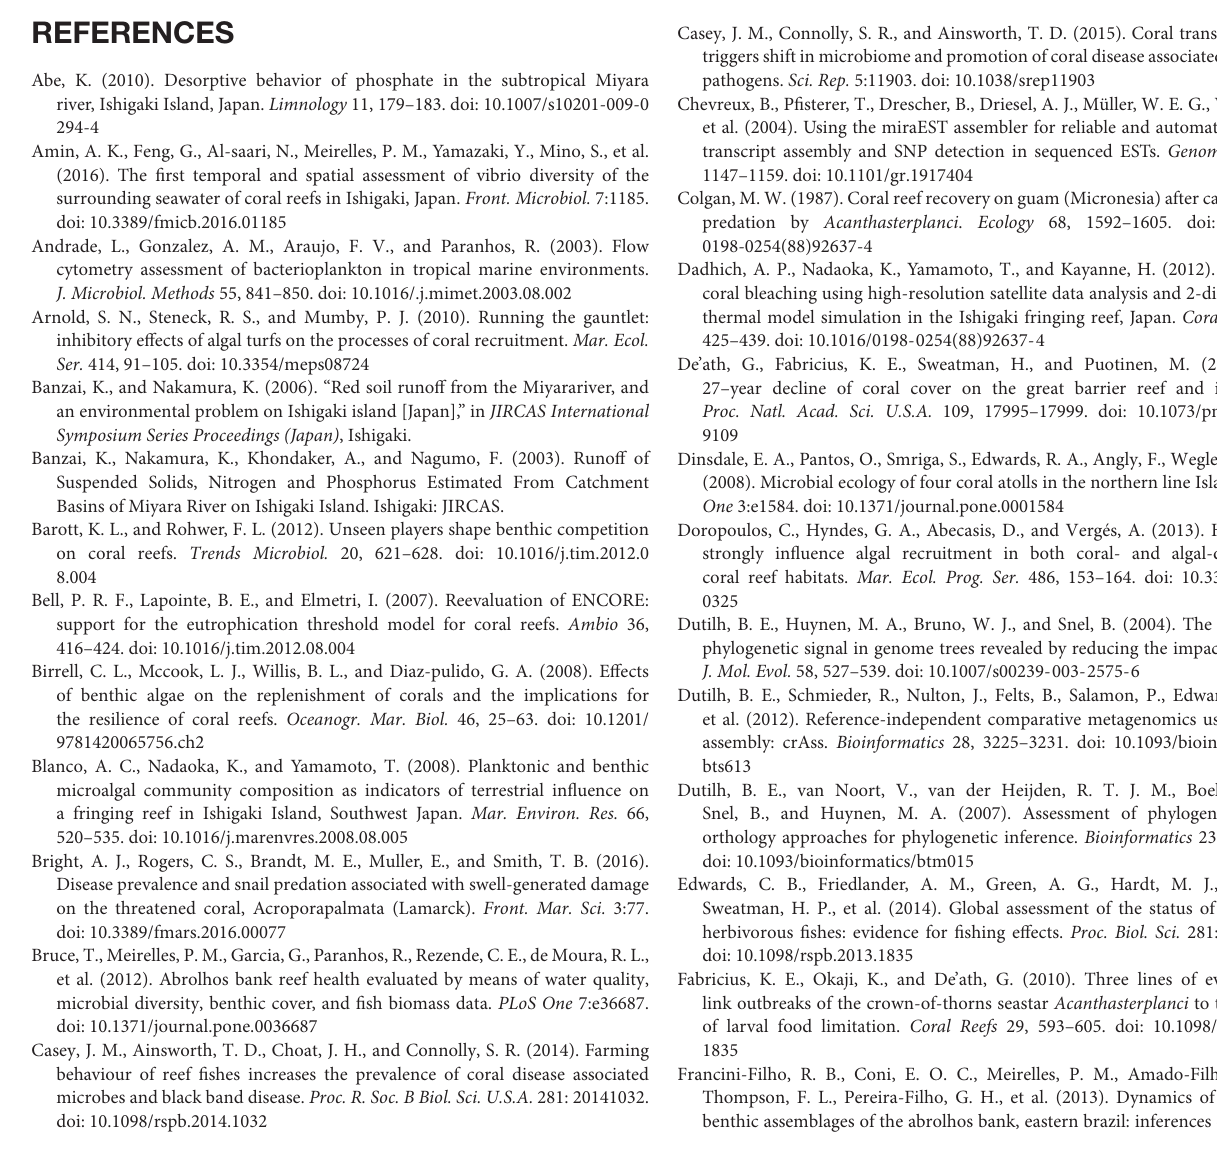
TABLE S9 | ANOVA results of nutrients and chlorophyll a concentrations. DF, degrees of freedom; SS, sum of squares; MS, mean sum of squares. TABLE S10 | Adonis (Permanova) results of metagenomic class composition (arcsin transformed) abundance based on Bray-Curtis distances with 999 permutations. MS, mean sum of squares; SS, sum of squares. TABLE S11 | Adonis (Permanova) results of metagenomic level 1 subsystem composition (arcsin transformed) abundance based on Bray-Curtis distances with 999 permutations. MS, mean sum of squares; SS, sum of squares. TABLE S12 | Adonis (Permanova) results of metagenomic dinucleotides composition abundance based on Bray-Curtis distances with 999 permutations. MS, mean sum of squares; SS, sum of squares. TABLE S13 | Wave characteristics extracted based on typhoon wave conditions. Hs: significant wave height (m); Dir: direction in degrees North; P: wave power